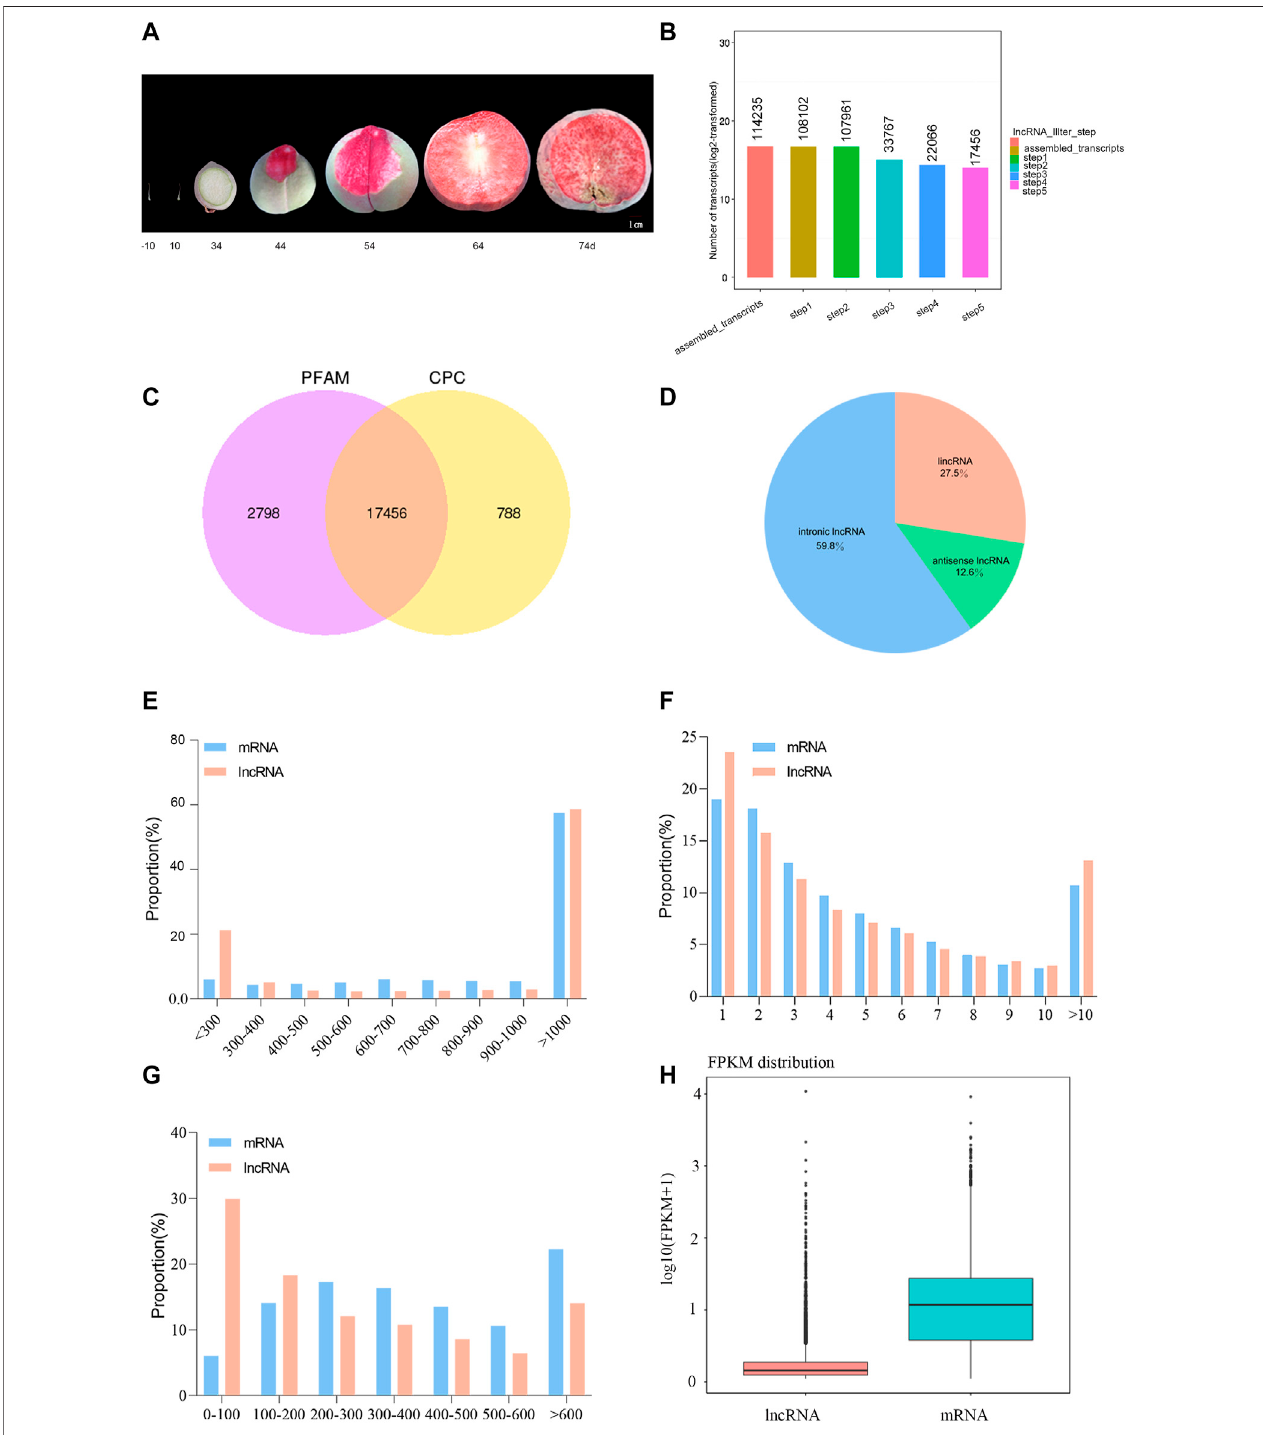
FIGURE 1 | General information on the lncRNAs in peach. (A) Phenogram of the peach. (B) Basic screening charts for lncRNAs. (C) Screening results using CPC and Pfam. (D) CompositionofdifferenttypesoflncRNAs. (E) Length distribution ofpeachlncRNAs andmRNAs. (F) DistributionofsomeexonsinlncRNAs andmRNAs. (G) Distribution of the ORFs in lncRNAs and mRNAs. (H) Comparison of expression levels between lncRNAs and mRNAs.